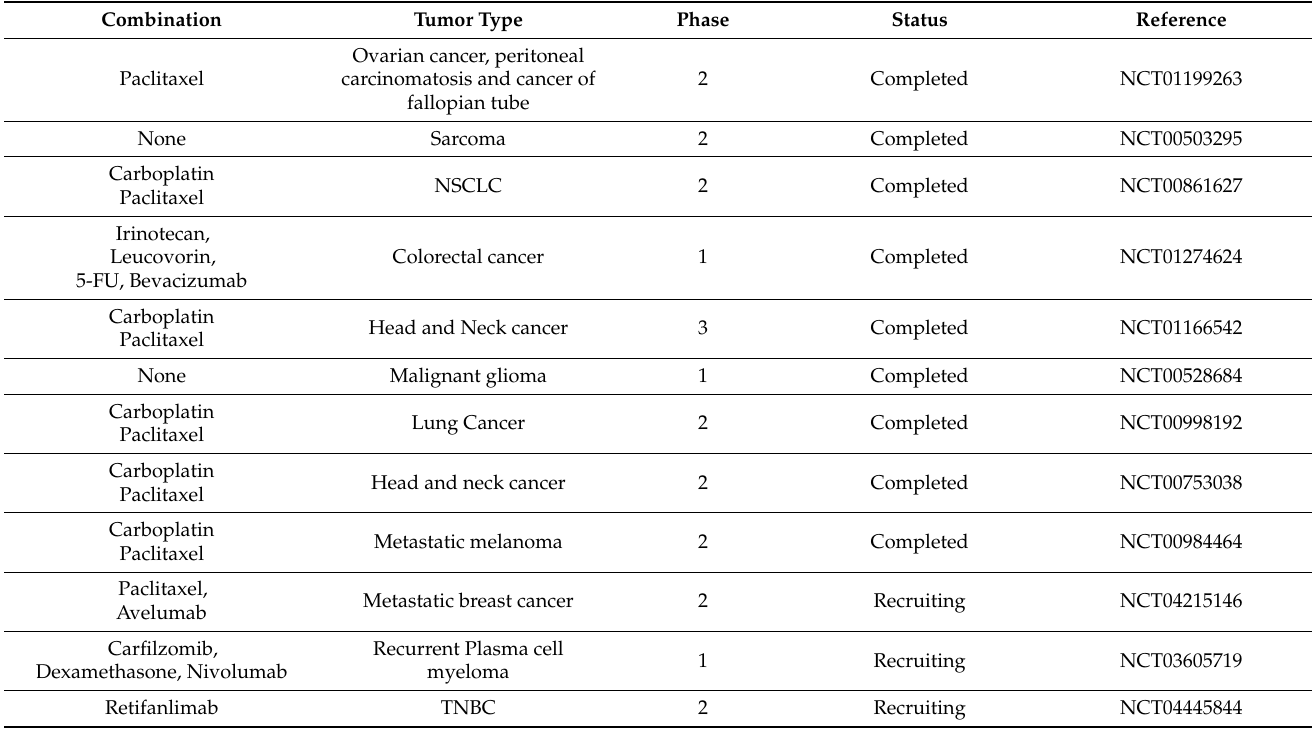
Table 4. Examples of clinical trials with